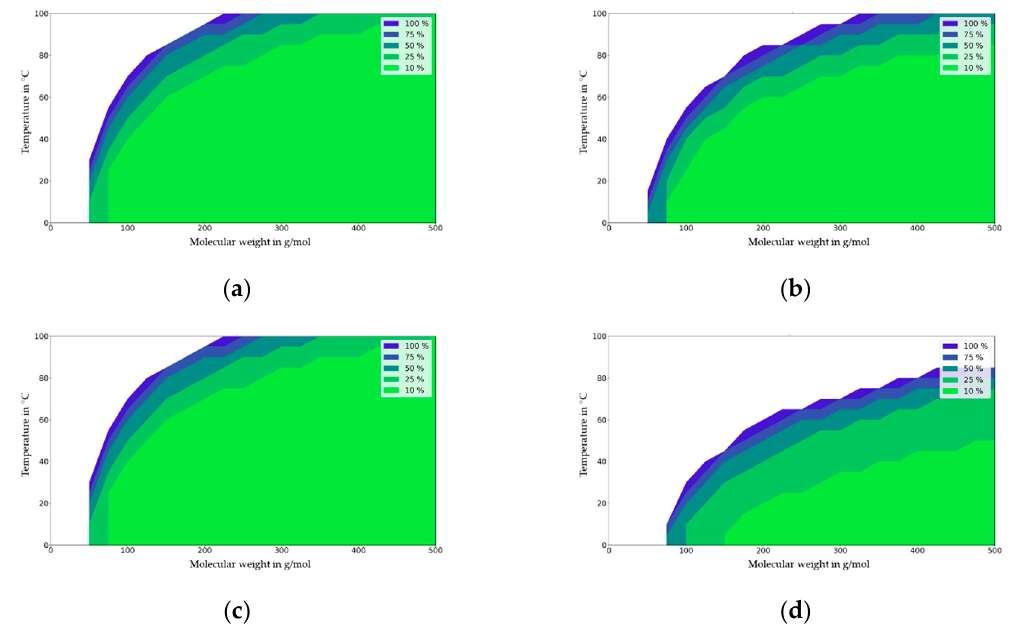
Figure 8. Single-use migration map for PET for contact times of 1 day ( a ) and 10 days ( b ) repeated-use migration map for contact times of 3 × 1 day ( c ) and 3 × 3 days = 9 days ( d ). Molecular weight in g/mol against temperature (T) in °C.